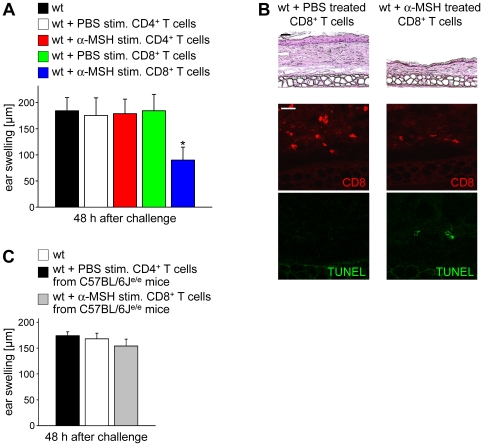
Alpha-MSH stimulated CD8+ T cells from wt mice suppress contact allergy responses.(A) Twenty-four h before challenge, DNFB-sensitized recipients were injected intravenously with 5×106 CD8+ T cells from wt donors that had been stimulated with PBS or α-MSH and co-cultured with DNBS-pulsed DC prior to adoptive cell transfer. Data are shown as mean ear swelling ± SD and are representative of 15 mice in three independent experiments. * P<0.05 vs. transfer of PBS stimulated CD8+ T cells. (B) Lymphocyte infiltrations and apoptotic cell death were determined by H&E (original magnification: 200×, scale bar  = 25 µm) or immunofluorescence staining of ear skin (original magnification: 300×, scale bar  = 25 µm). (C) MC-1R mediated signaling in CD8+ T cells is required for the suppression of contact allergy. Twenty-four h before challenge, recipients were injected intravenously with 5×106 PBS or α-MSH stimulated CD8+ T cells from C57BL/6Je/e mice. Data are shown as mean ear swelling ± SD and are representative of 10 mice.